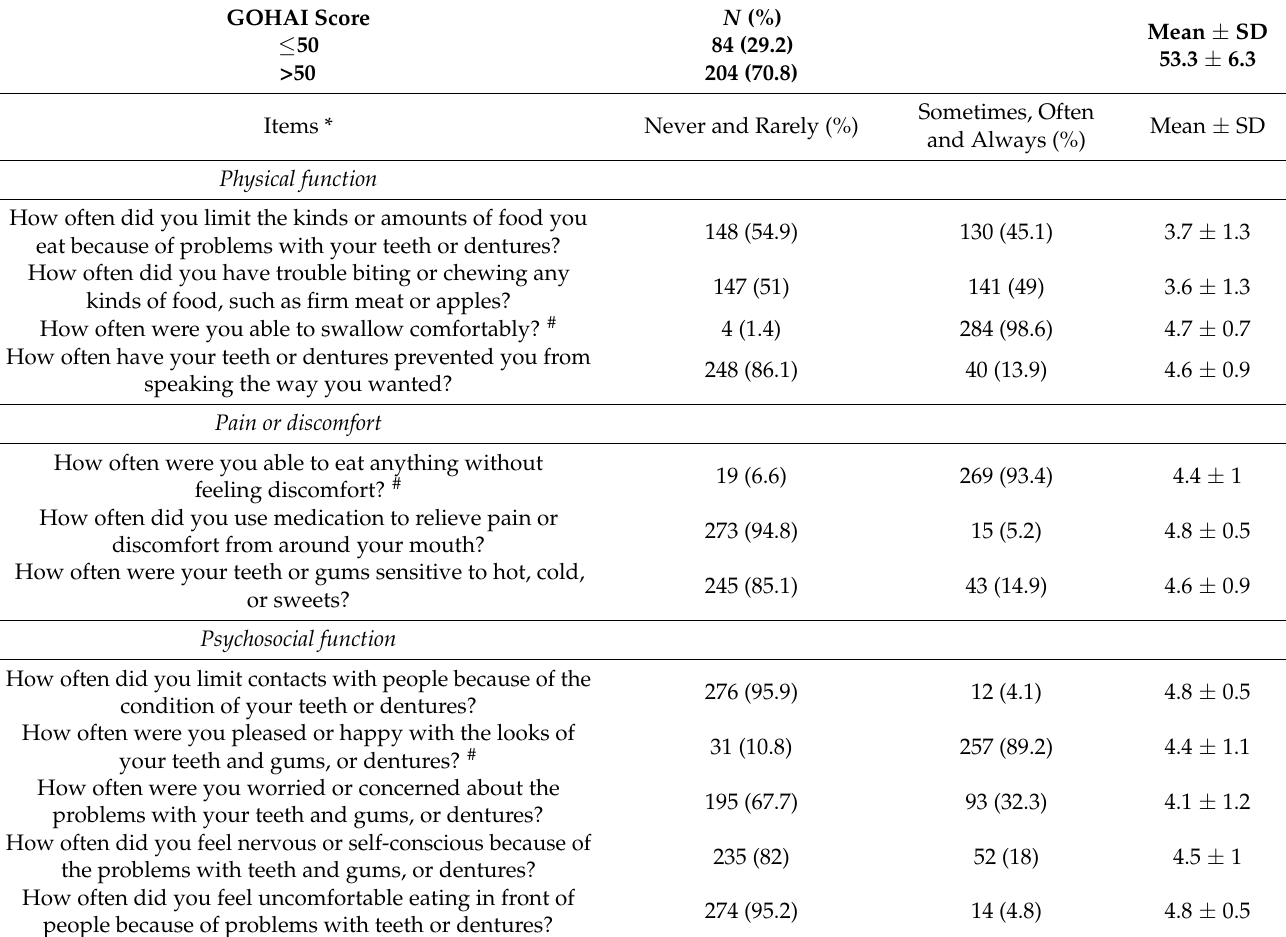
Table 2. Distribution of GOHAI by